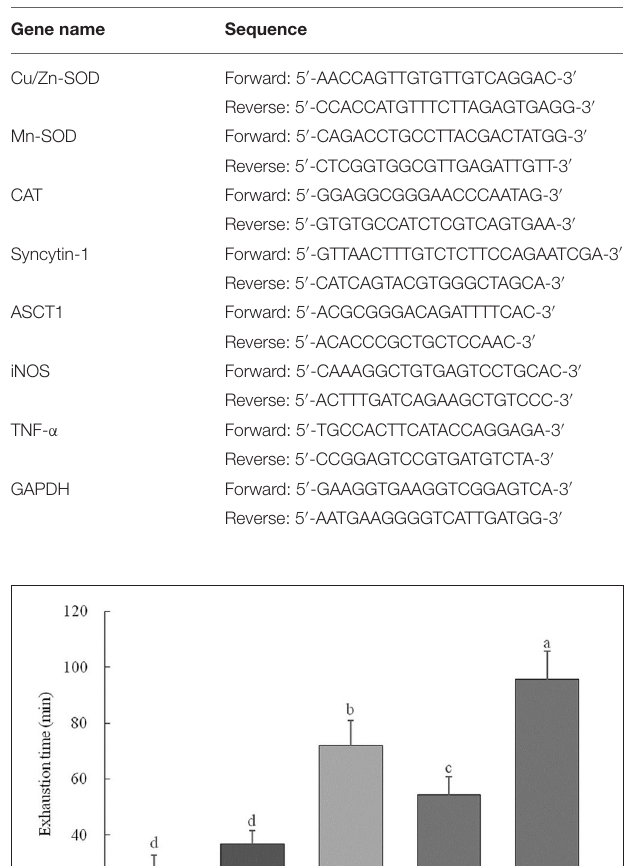
TABLE 1 | Sequences of the primers used for this experiment.